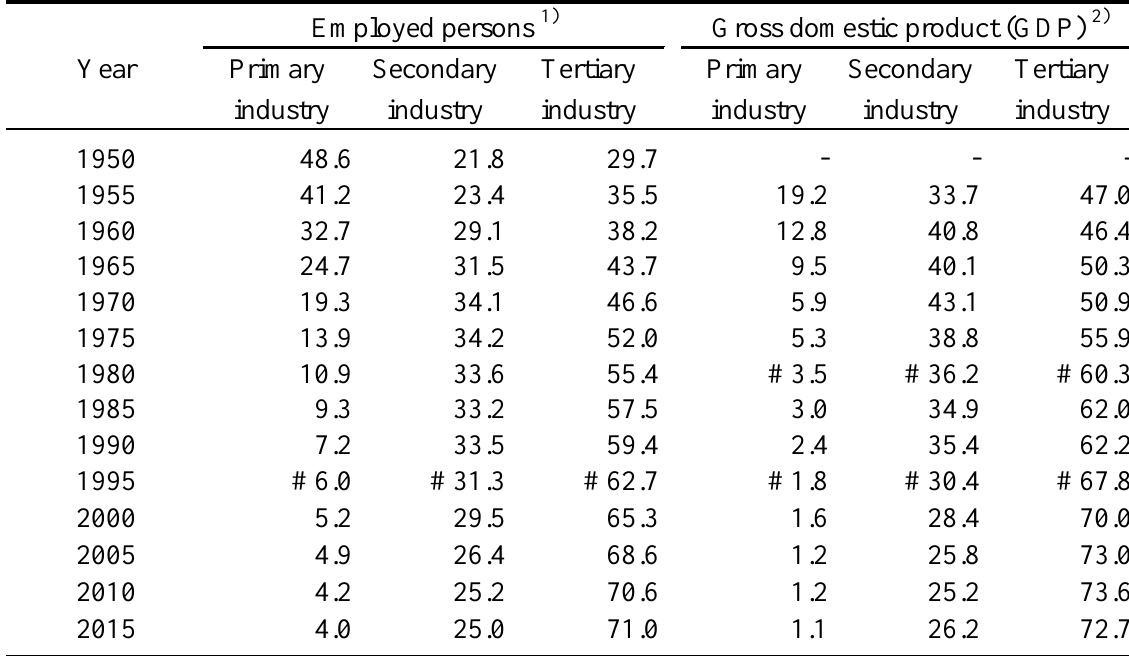
Changes in Industrial Structure